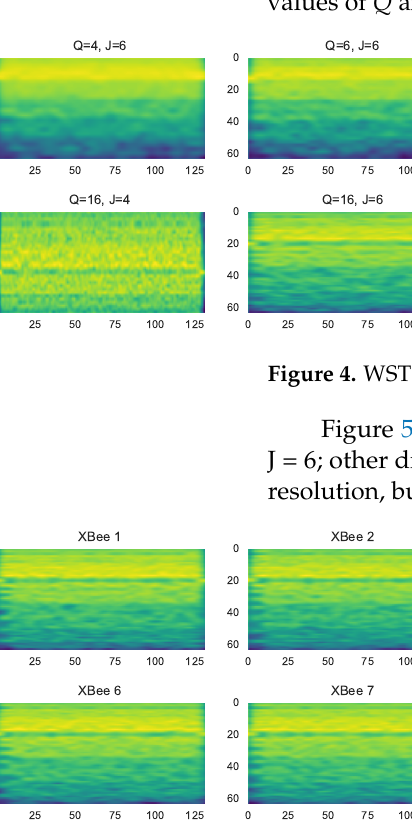
Figure 5. WST from different 10 XBee